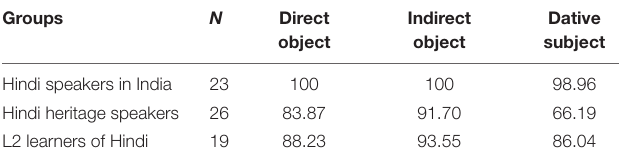
TABLE 5 | Elicited Production Task.